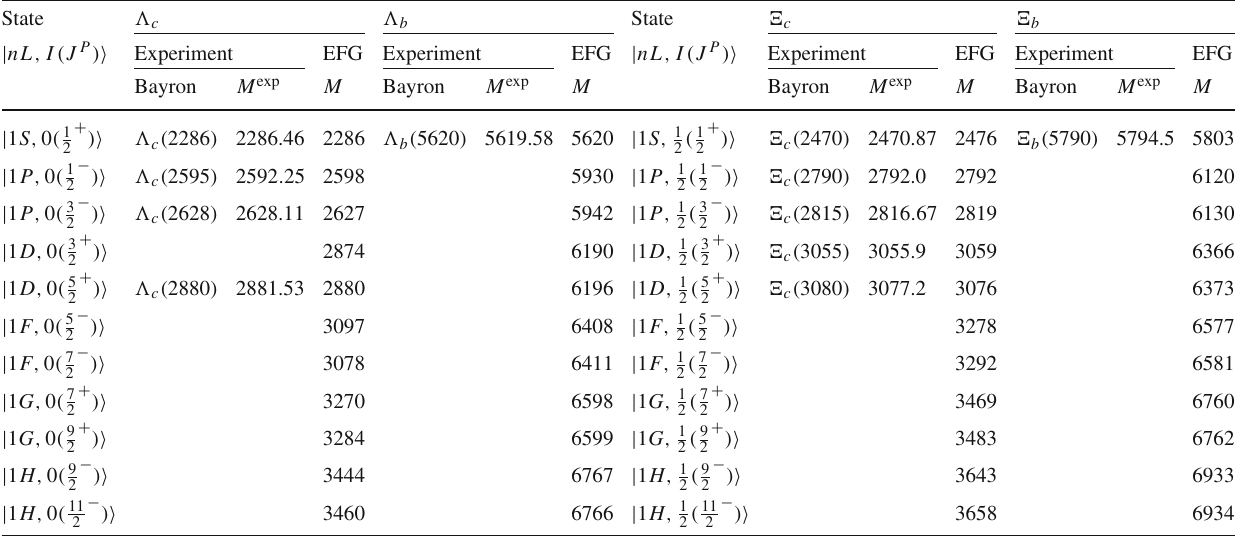
Table 3 The experimental [16] and EFG model values [18] for (cid:5) Q and (cid:7) Q baryons with a good diquark ( S qq = 0). Here, the constituent quark masses [17] we adopted to analyze the experimental data as well as EFG calculations are given by Eq. (10)